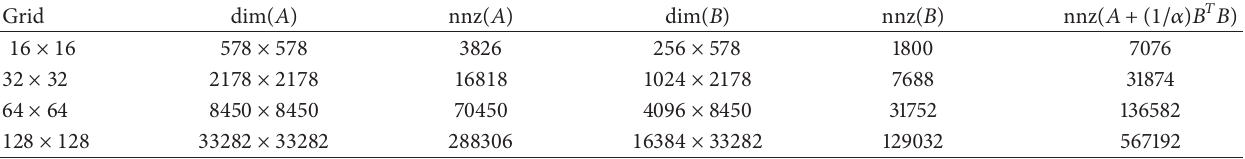
Table 14: Size and number of non-nil elements of the coefficient matrix generalized by using Q1-P0 FEM in steady Stokes problems. Grid dim( 𝐴 ) nnz( 𝐴